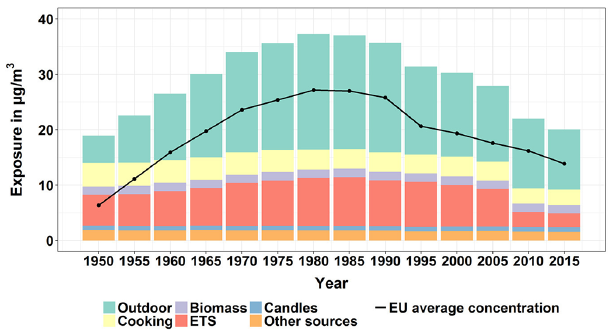
Figure 17. Temporal evolution of the annual average exposure of EU adult persons to PM 2 . 5 from 1950 to 2015 (Li and Friedrich, 2019). All sources, except “outdoor”, refer to indoor sources. ETS denotes environmental tobacco smoke (passive